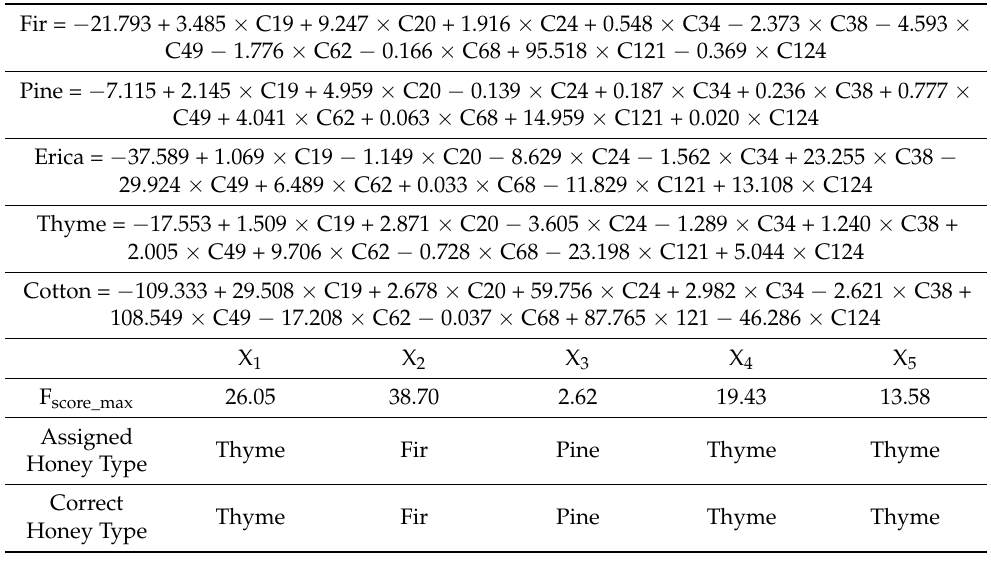
Table 4. Fisher’s linear discriminant functions exported for the 5 monofloral honey types (test set) and assignment of probable botanical origin for five samples (references